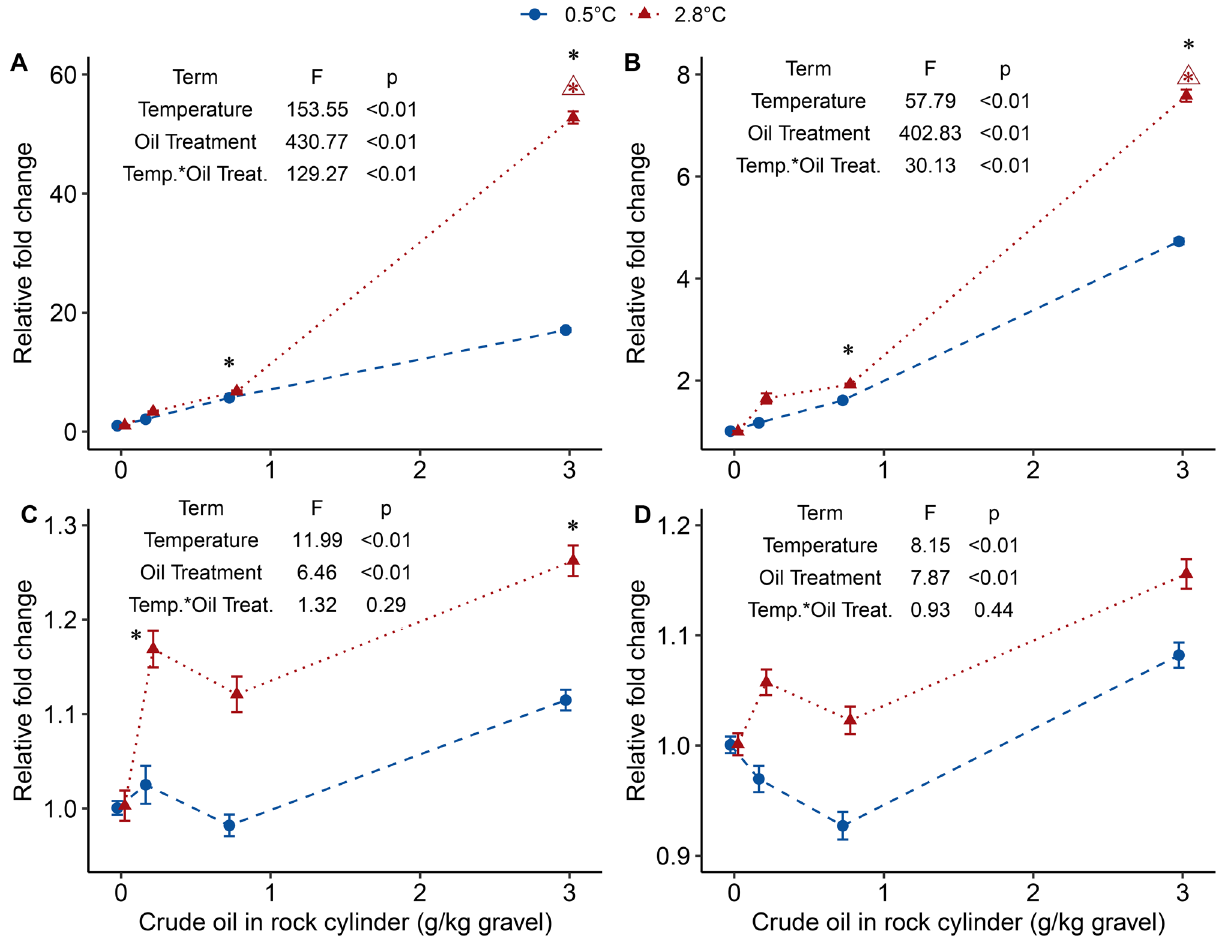
Figure 3. The effect of temperature and WSF crude oil exposure on gene expression of ( A ) cyp1a , ( B ) cyp1c1 , ( C ) hsp 70 , and ( D ) hsp 8 measured by qRT PCR in embryos just prior to hatch (day 28 at 2.8 °C and day 48 at 0.5 °C). Data is displayed as treatment means (± SEM depicted as bars, each treatment is represented by four independent incubator pools of 50 embryos each). Colors and symbols indicate temperature groups and dashed and dotted lines represent the LME model trend line for each temperature group. The terms of the linear mixed effect model for each gene and the ANOVA F-values and p-values are displayed in each panel. An asterisk (*) above a treatment group indicates a statistically significant difference from the unexposed group, a triangle (open triangle) with an asterisk indicates a statistically significant interaction between temperature and crude oil exposure at the adjacent crude oil treatment